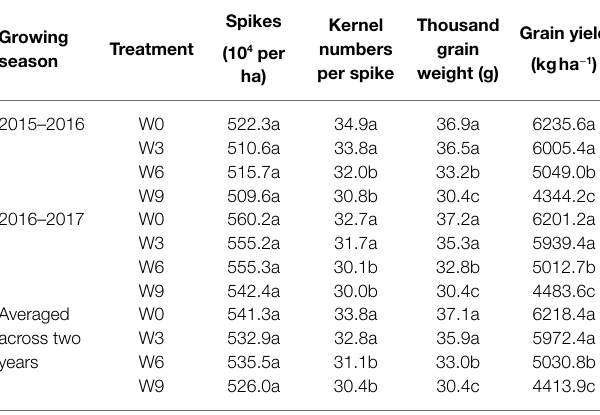
TABLE 1 | Wheat yield and its components under different waterlogging treatments at crop